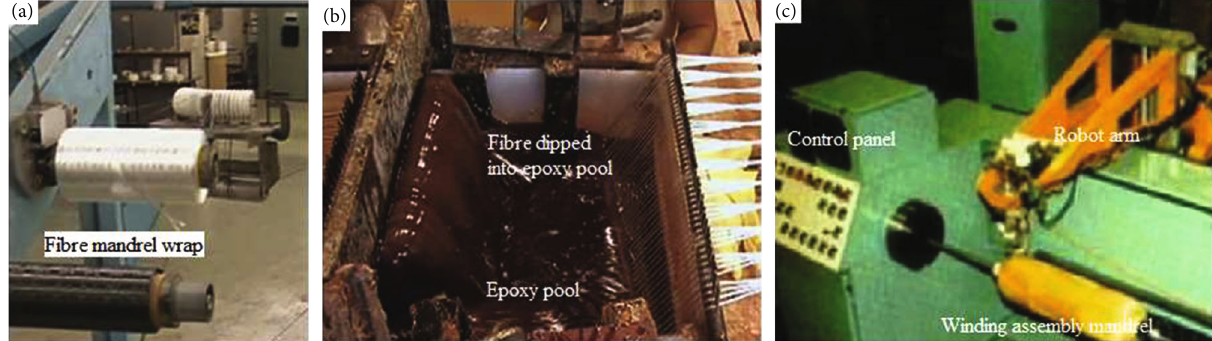
Figure 1: Actual fabrication setup of wet winding machine. (a) Fibres are placed in roving roller, (b) resin bath, and (c) fi lament-winding robot arm with a fabric mat.